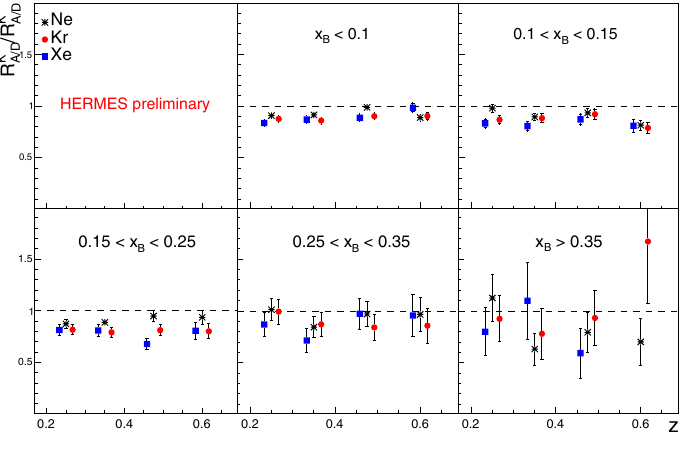
Figure 4. R K − ( z ) / R K + ( z ) dependences for charged kaons at five x B slices A / D A / D